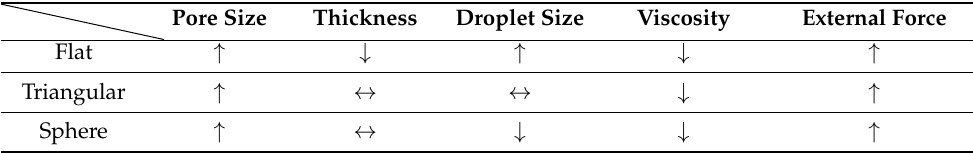
Table 2. Evaluation of oil–water separation with different